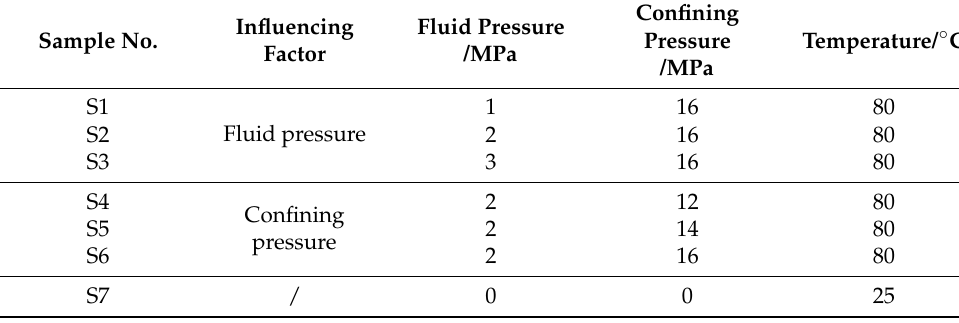
Table 2. Designed forcible imbibition experiments on shale samples.